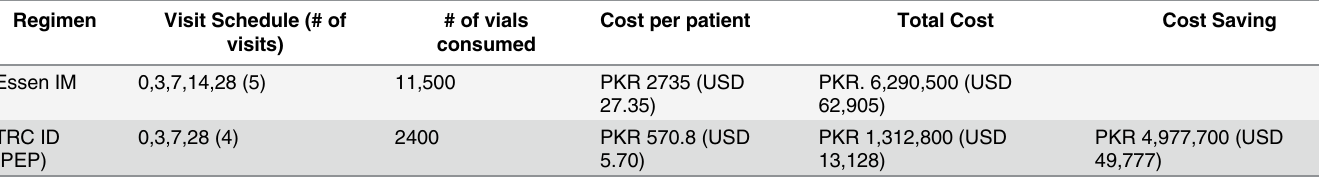
Table 3. Cost savings of vaccine by using TRC – id regimen for 2300 patients. Regimen Visit Schedule (# of